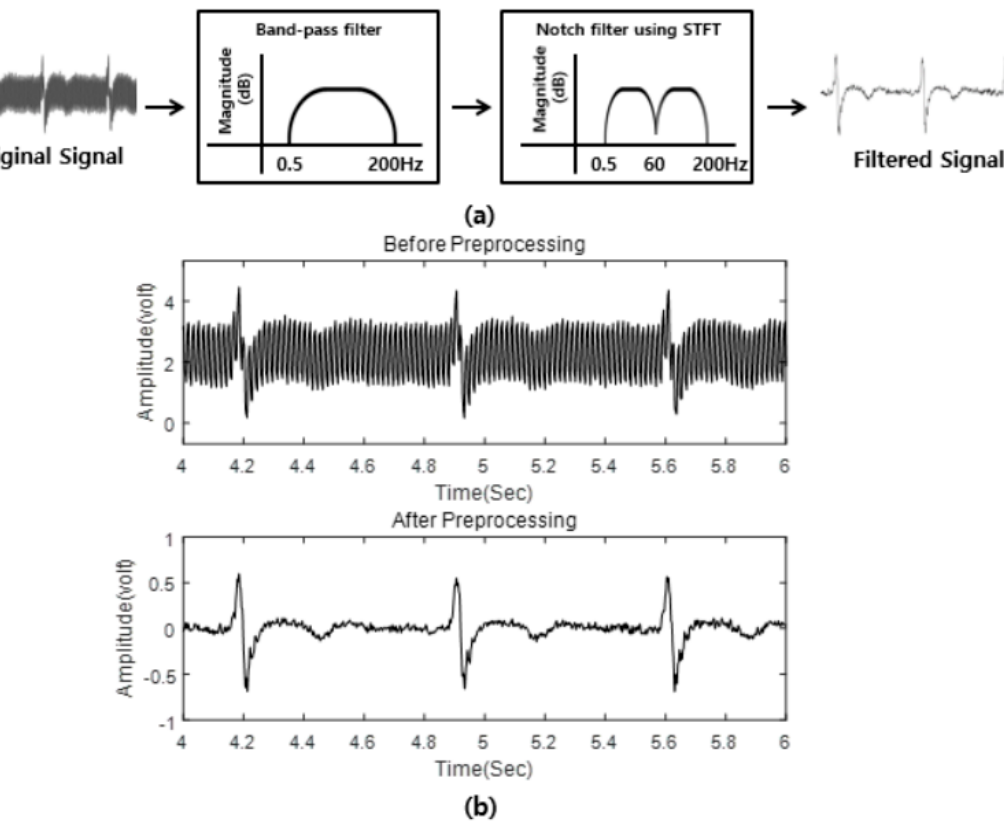
Figure 3. ECG signal preprocessing. ( a ): The simplified block diagram of signal preprocessing, where the BPF and notch filter are applied to remove the noise and power line interference related harmonics